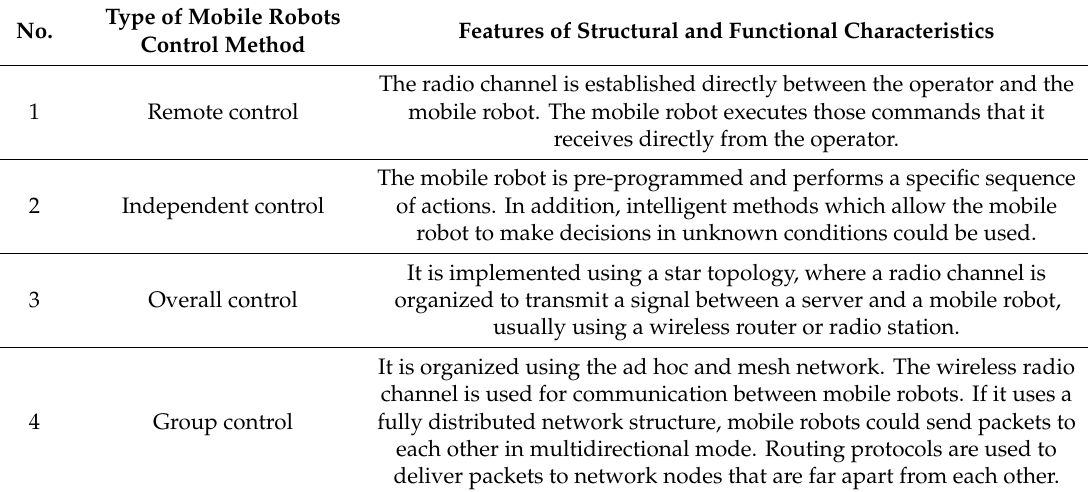
Table 1. The types of Mobile Robots Control Method and ways of organizing and building the networks.